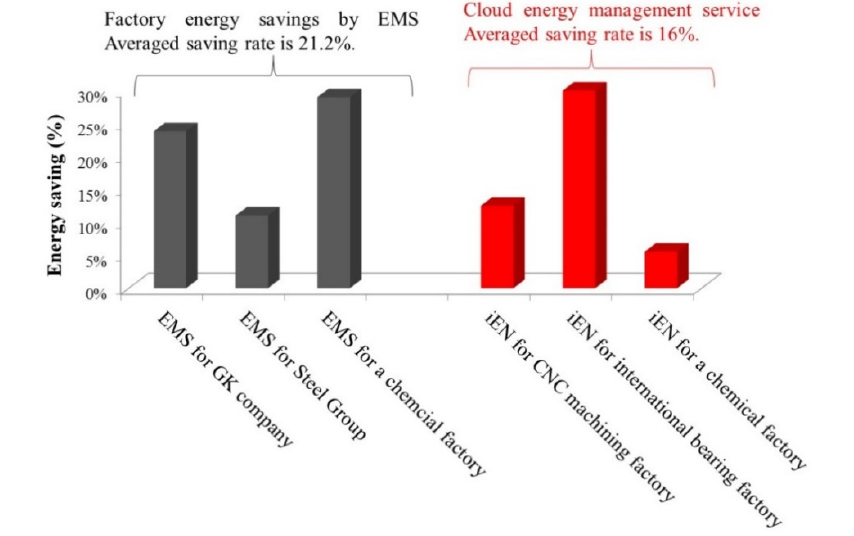
Figure 3. Comparison of energy savings of factories by applying EMS and iEN.